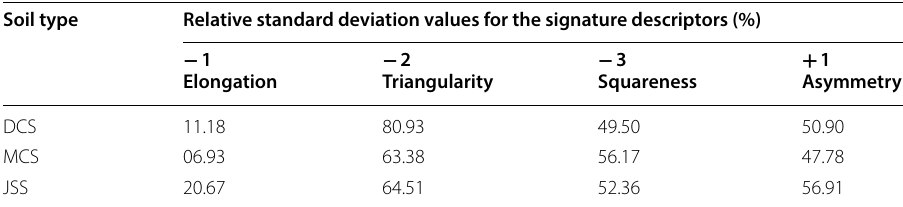
Table 3 General shapes used to investigate Fourier descriptors for morphological characterization, relative standard deviation values for the signature